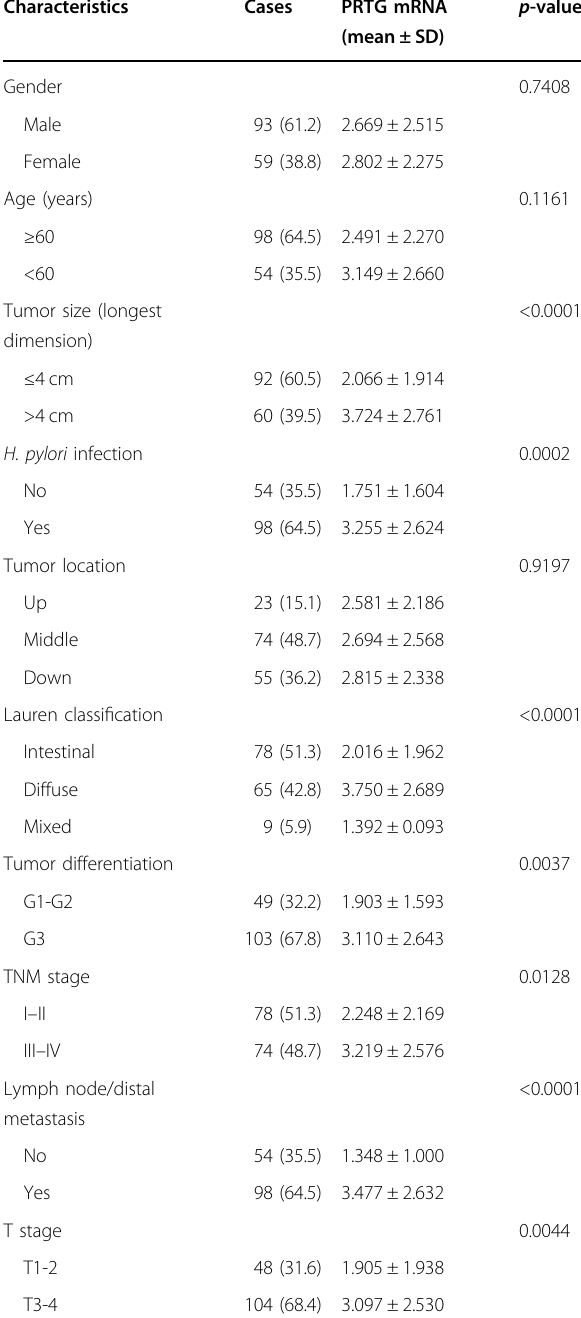
Table 1 Association between PRTG expression and clinicopathologic characteristics of gastric cancer patients from local